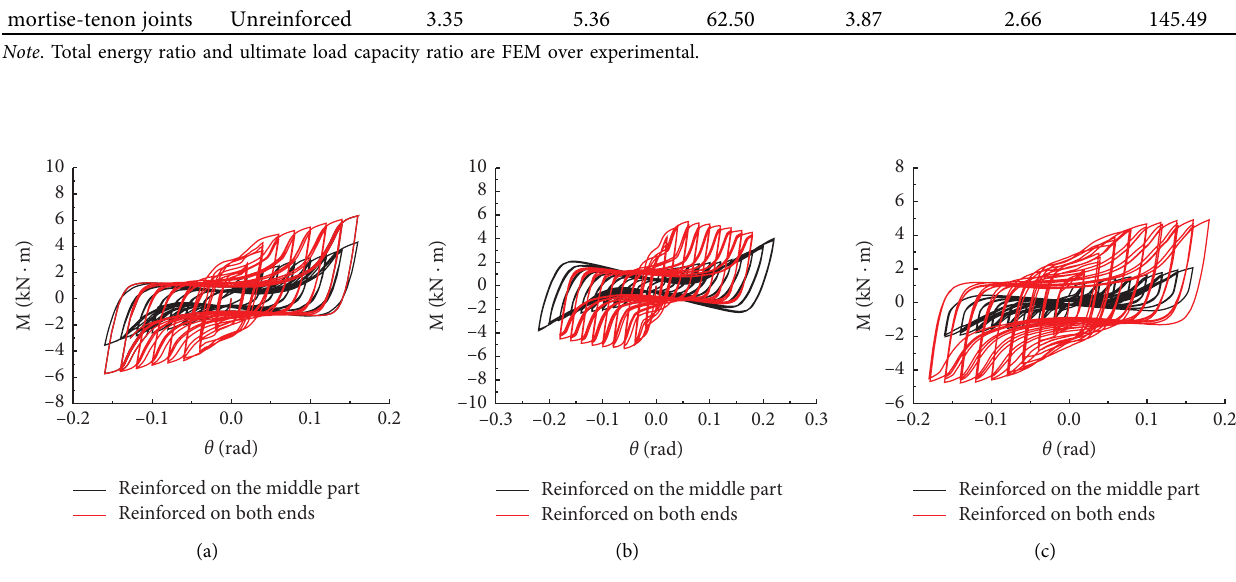
Figure 22: Comparison of h moment-rotation hysteretic loops of joints at diferent reinforcement positions of steel plates: (a) Tou mortise- tenon joints. (b) Ban mortise-tenon joints. (c) Dovetail mortise-tenon joints.